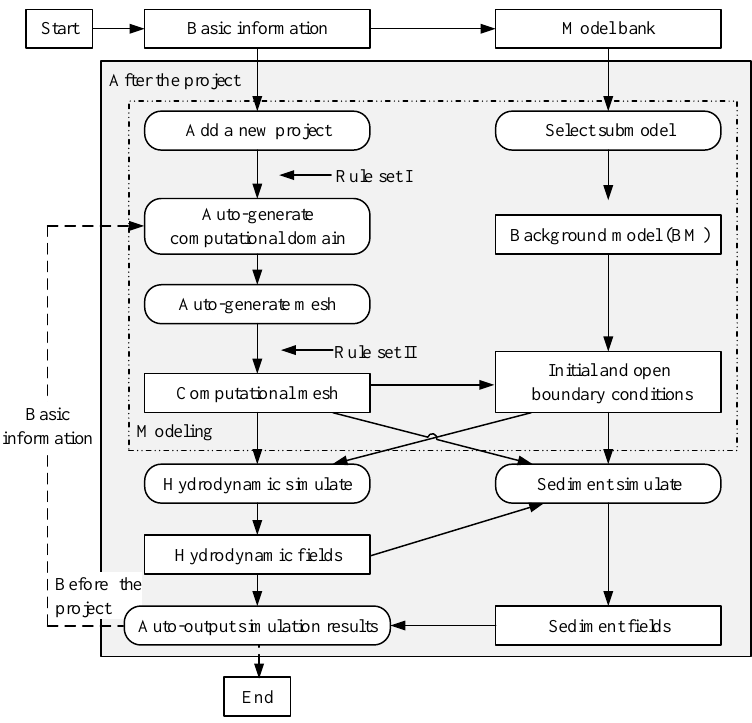
Figure 4. Automatic hydrodynamic-sediment program workflow.